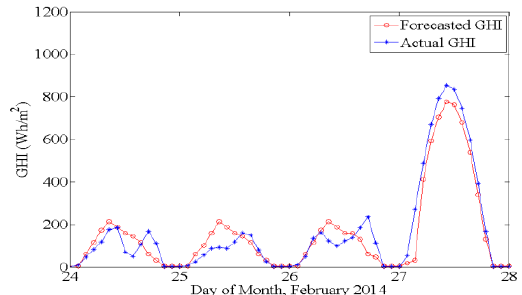
Figure 8. Comparison between two-days-ahead forecasted and actual GHI for 3 overcast and 1 clear day (type 3).